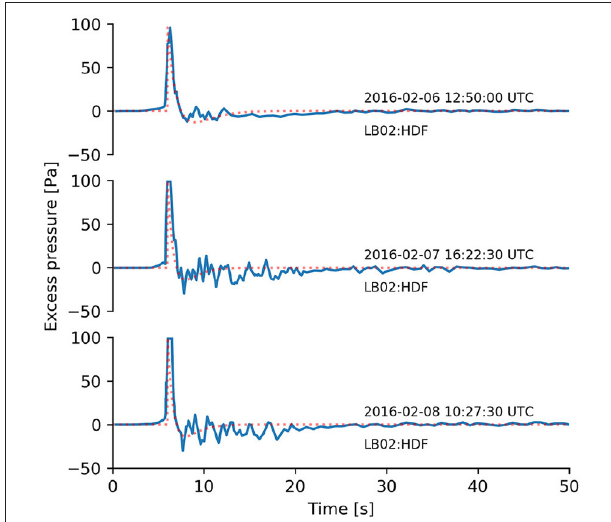
FIGURE 7 | Infrasonic acoustic waveforms (blue line) from three large explosions in early February 2016 as recorded at station LB02. Each event is overlain with the modeled Friedlander wave (red dashed line) that indicates the blast wave nature of the events.